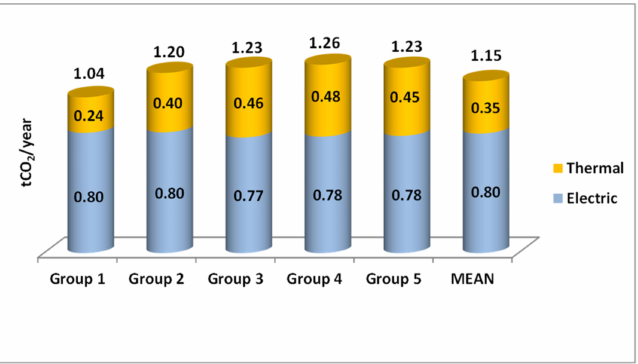
Figure 14. Thermal, electric, and total CO 2 emissions per inhabitant by group of cities.